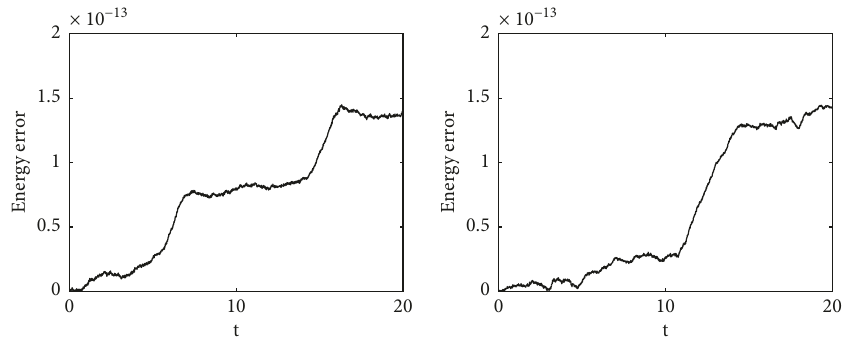
Figure 4: Energy errors for the second-order AVF method in t